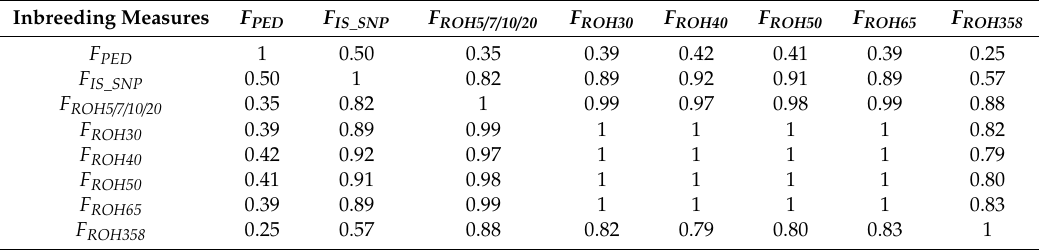
Table 6. Pearson correlation coe ffi cients between the genomic inbreeding coe ffi cient F ROH20 or F ROH50 and the pedigree inbreeding coe ffi cient F Ped by number of complete generations. The correlation coe ffi cient with a p -value < 0.0001 between F ROH20 or F ROH50 and F Ped is given. Either all dogs or those with more than three, four, five, or six complete generations in the dataset were regarded in the calculations. Complete Generations Correlation F